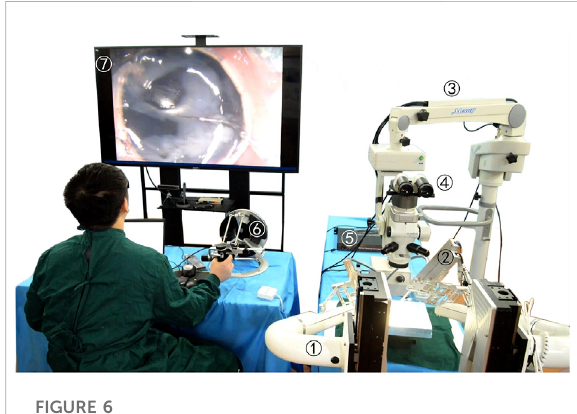
FIGURE 6 Microscopic image guidance robot-assisted pig eyeball retinal veininjection. (1)Dual-armsurgicalrobot.(2)Druginjection device. (3) Microscope. (4) Spectroscope and cameras. (5) FBG demodulator. (6) Omega 6. (7) 3D microscopic image.